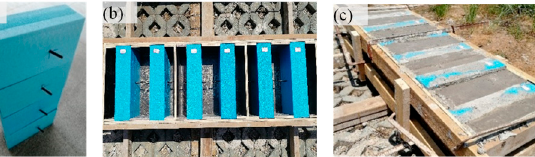
Figure 3. Manufacturing process: ( a ) Installation of connector; ( b ) Fix of insulation layer; ( c ) Concrete casting and curing.